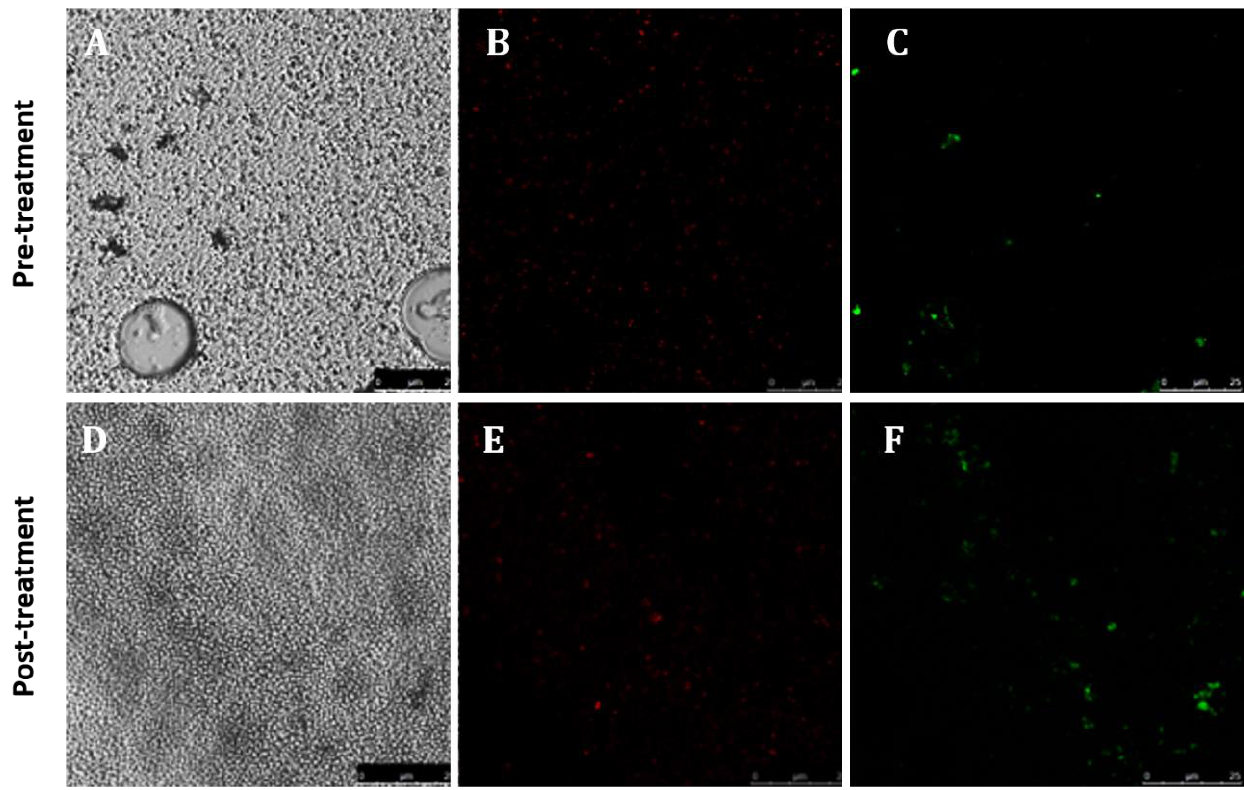
Figure 1. Confocal electron microscopy images of pre- and post-treatment using 32 mg/L of F-DPC ((F-gH625C)SucG 2 (SNHMe 2 Cl) 4 ) ( 2 ). ( A ) Treated biofilm structure (phase), ( B ) PI signal: dead cells (red channel), ( C ) F-gH625C signal (green channel), ( D ) treated biofilm structure (phase), ( E ) PI signal: dead cells (red channel), ( F ) F-gH625C signal (green channel).